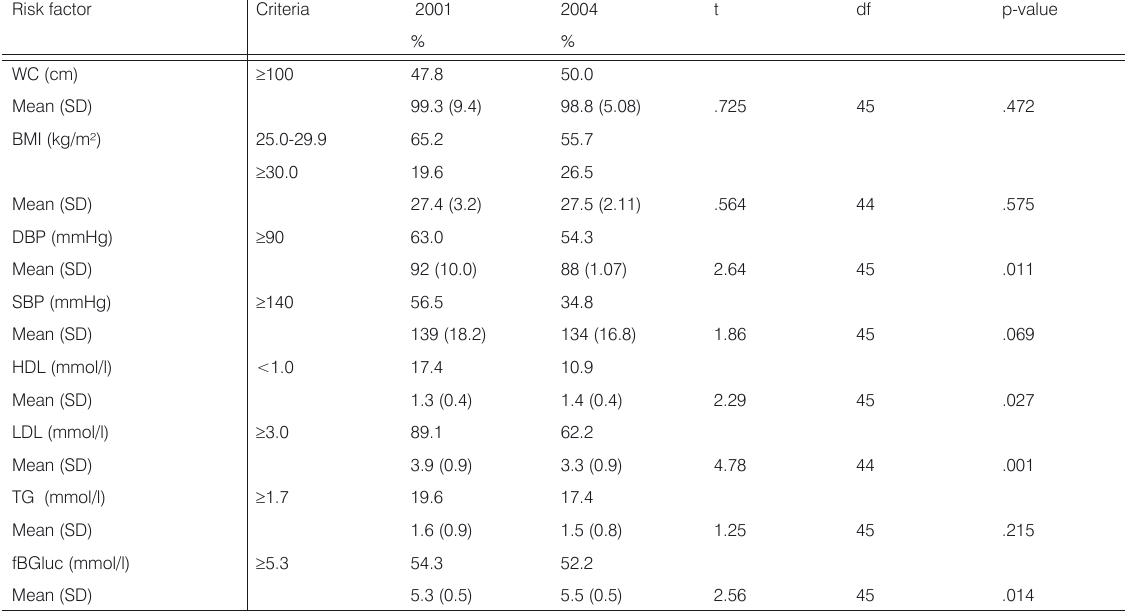
Table 1. Risk factors at baseline in 2001 and in 2004